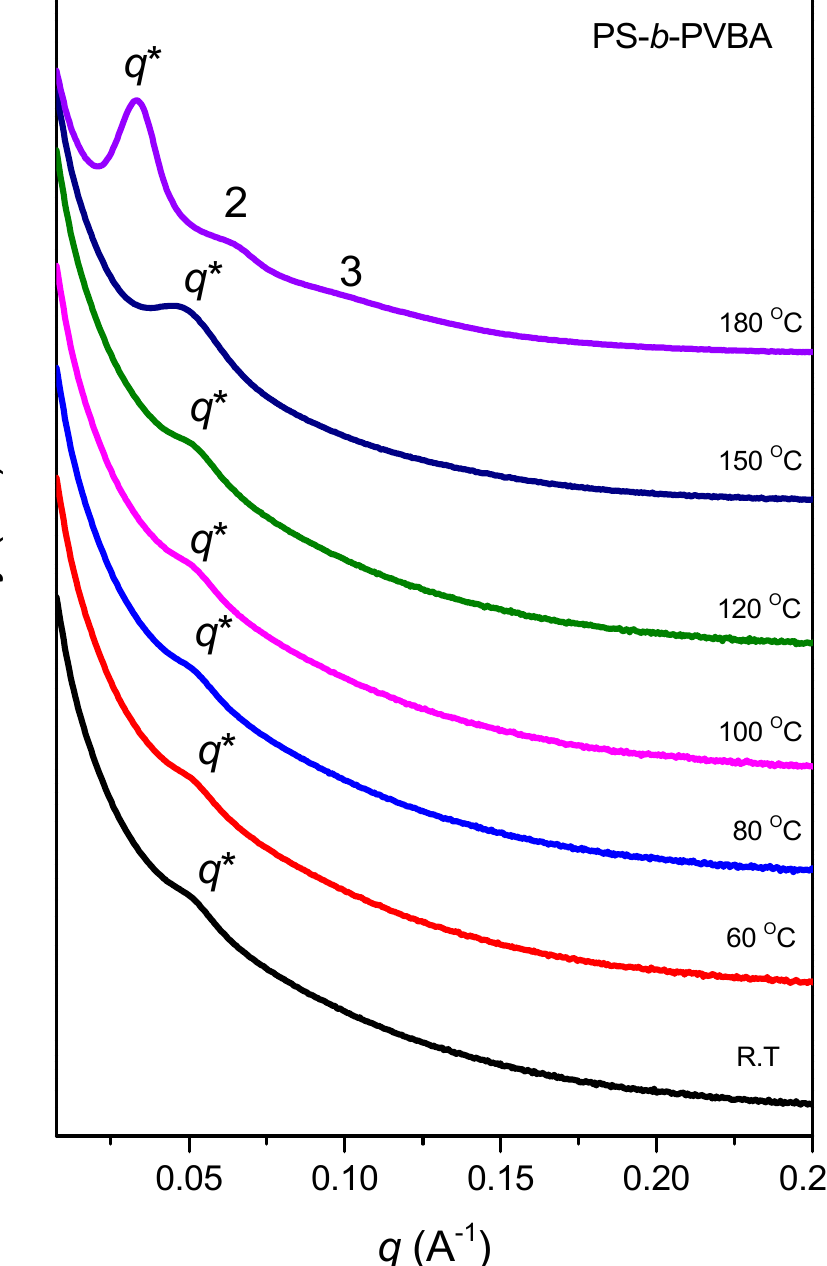
Figure 7. SAXS analyses of the pure PS- b -PVBA diblock copolymer, recorded at various temperatures.